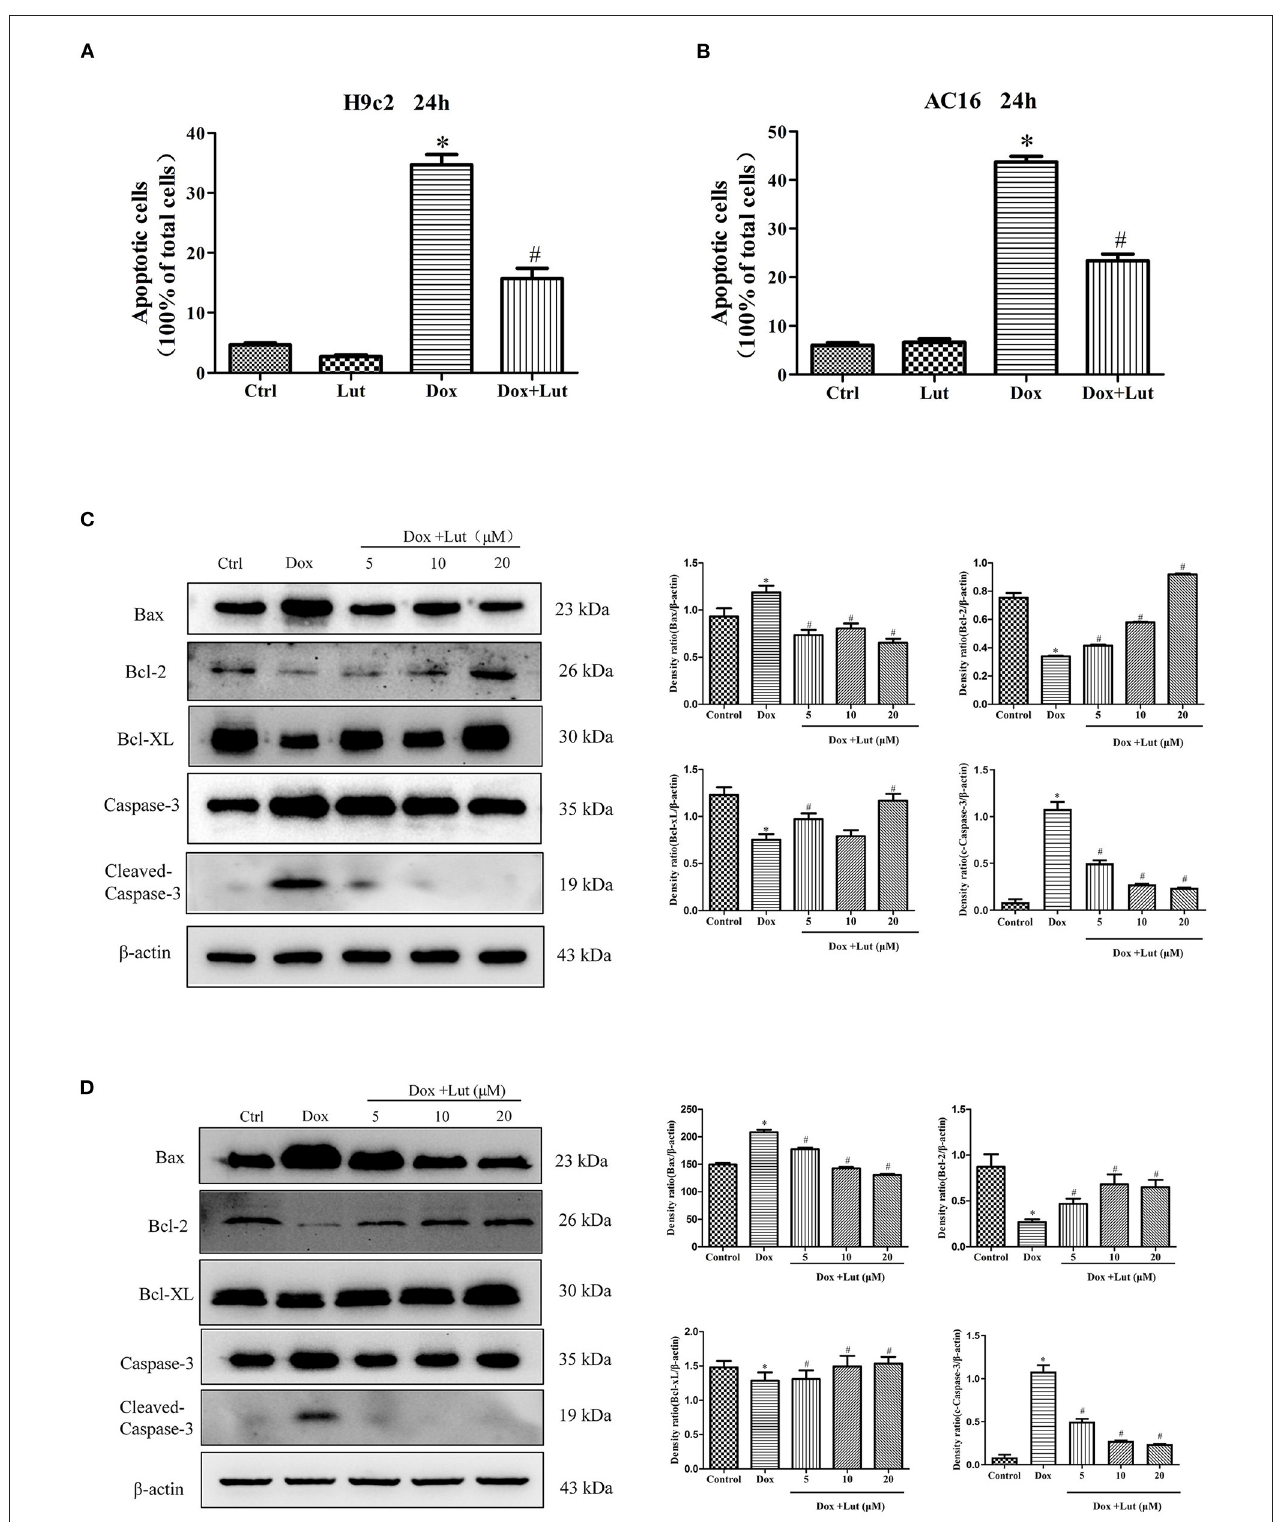
FIGURE 3 | Effect of Lut treatment on Dox-induced cardiomyocyte apoptosis. (A) Quantified TUNEL-positive cells from three fields per group in H9c2 and (B) AC16 cells. (C) Representative Western blot images of H9c2 and (D) AC16 apoptosis using Bax, Bcl-2, Bcl-XL, and Cleaved Caspase-3. Mean ± SD, n = 3 independent experiment. * P < 0.05 compared with control group. # P < 0.05 compared with Dox group.